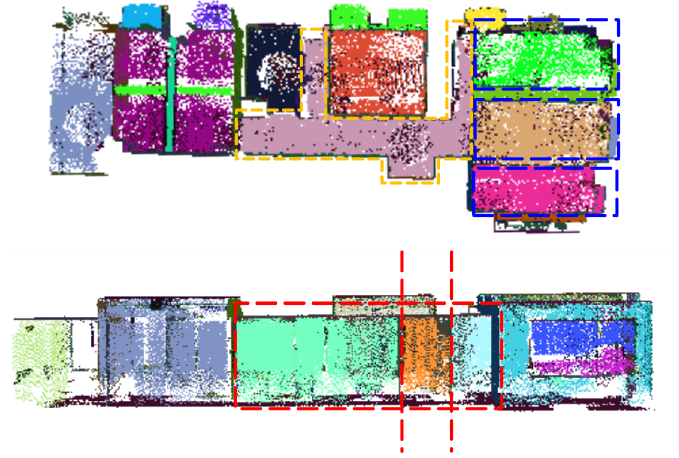
Figure 6. The top-down view and side view results of planar primitive detection (rendered in different